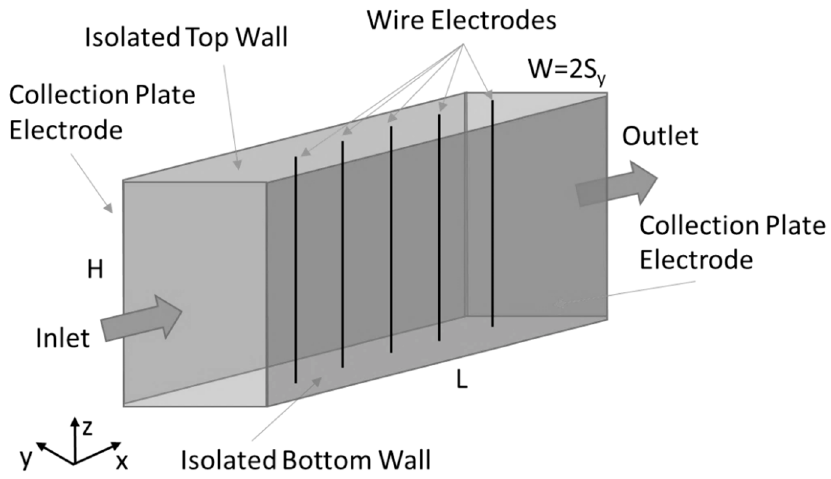
Figure 1. Schematic of the ESP model.